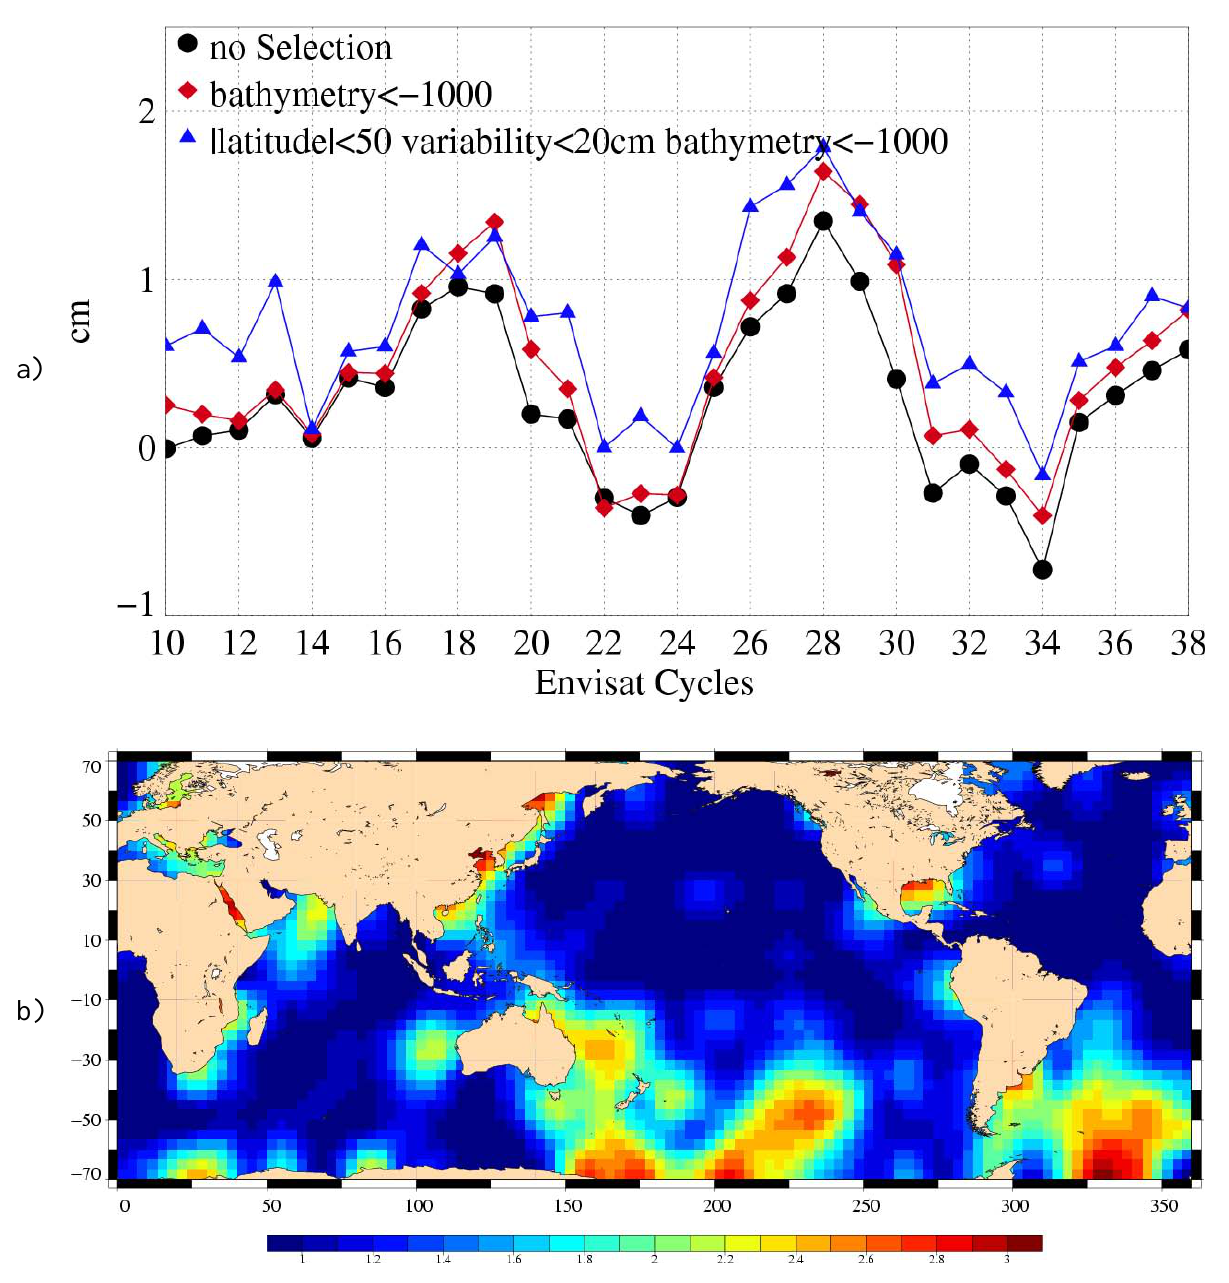
Figure 15. Time varying 35-day crossover mean differences (cm). a) Cycle per cycle Envisat crossover mean differences. An annual cycle is clearly visible. Diamonds: shallow waters (1000 m) are excluded. Triangles: shallow waters excluded, latitude within [-50S, +50N], high ocean variability areas excluded b) Map of the geographic distribution of the amplitude of the annual cycle of the crossover means shown in a) averaged in 10deg x 10deg geographical bins (after